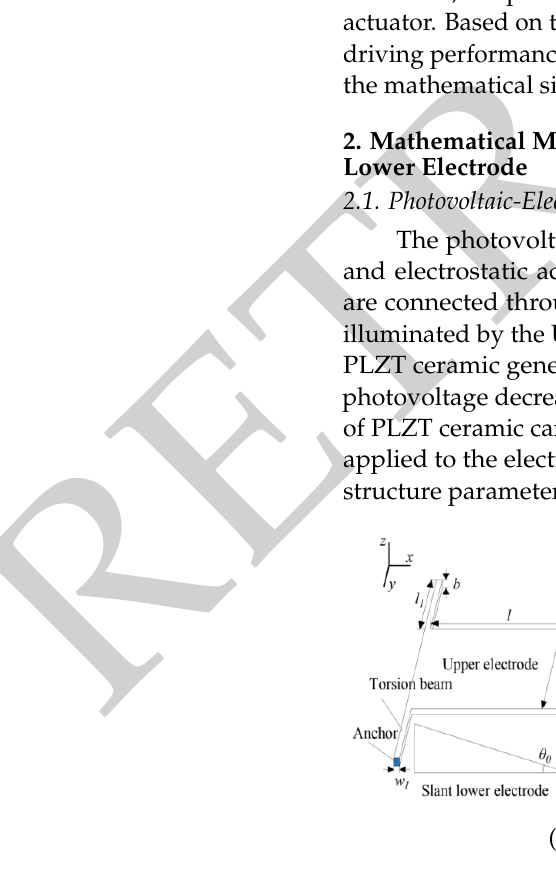
Figure 1. Schematic diagram of the photovoltaic-electrostatic hybrid actuator with a slant lower electrode. ( a ) The structure parameters of the actuator. ( b ) Force condition of the actuator. Table 1. The structure parameters of the photovoltaic-electrostatic hybrid actuator. Parameters Value Width of the torsion beam ( w 1 ) 10 μm Thickness of the torsion beam ( b )